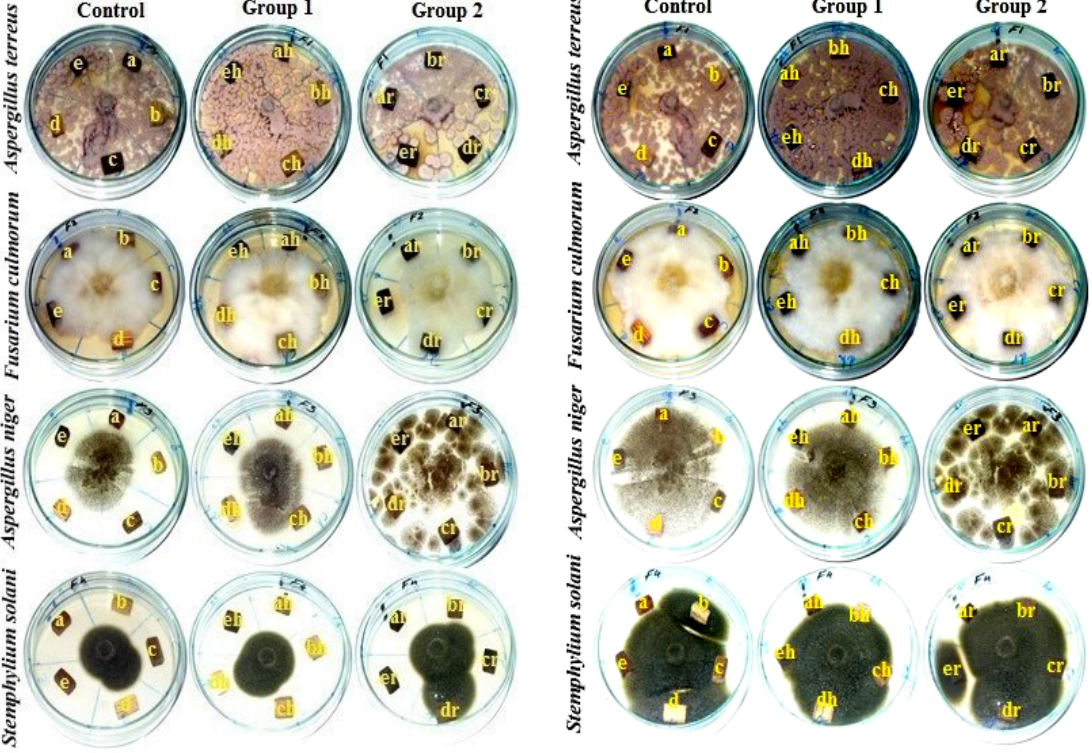
Figure 9. Effects of ageing on five types of wood against four mold fungi.